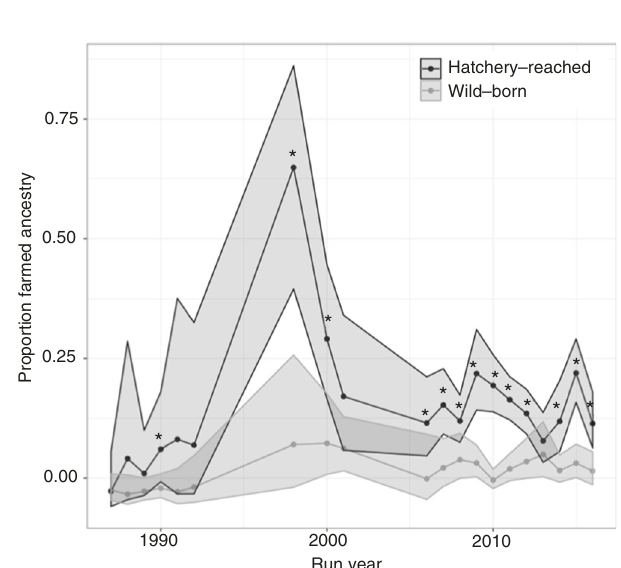
Fig. 2 Introgression in hatchery-reared and wild-born adult spawners. Hatchery-reared adults ( n = 1567) were more introgressed than wild-born adults ( n = 1347) across all years compared. Dots are the estimated average for level of proportion farmed ancestry for wild-born and hatchery- reared adults, respectively. Lines connect the different run years. Shaded areas represent standard error. Differences in introgression between wild- born and hatchery-reared adults were tested using a generalised linear mixed model with a logit link. Differences that are signi fi cant at alpha level 0.05 or less are denoted with stars. See Supplementary Table 9 for details on sample sizes and signi fi cance levels. Source data are provided as